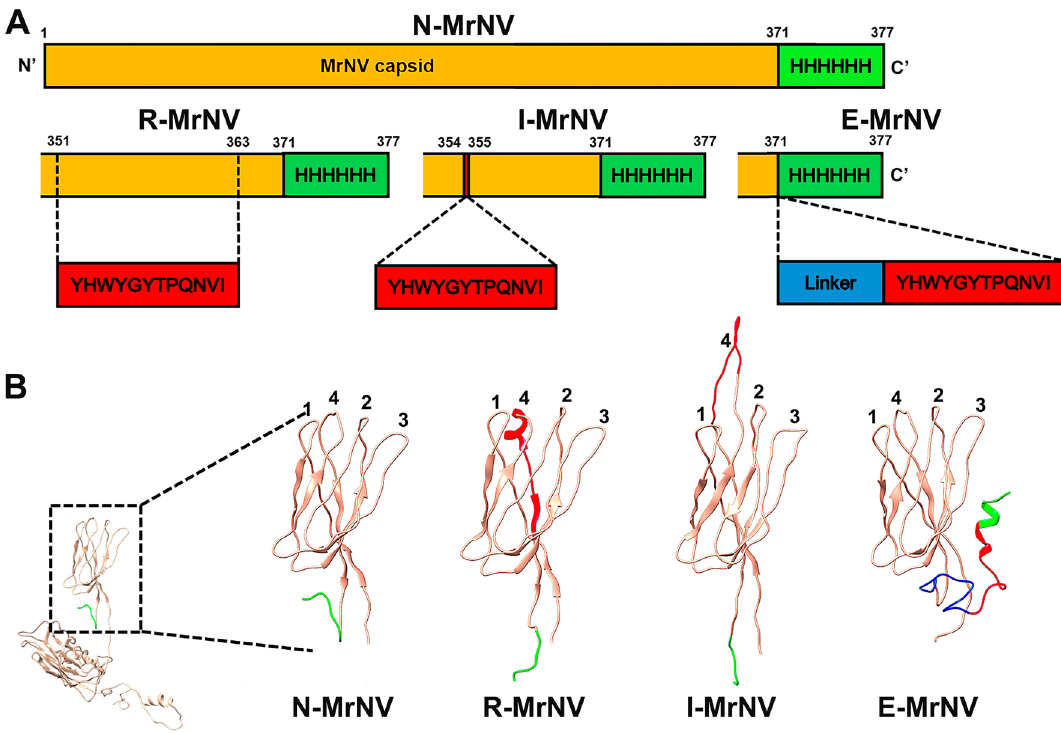
Figure 1. The schematic diagram of the construction of chimeric GE11 + MrNV-VLPs. In silico ribbon diagram of P-domain of 4 typed chimeric MrNV-VLPs including N-MrNV, R-MrNV, I-MrNV, and E-MrNV generated by Phyre2 algorithm version 2.0 (http:// www. sbg. bio. ic. ac. uk/ phyre2) and Chimera software version 1.14 (https:// www. cgl. ucsf. edu/ chime ra). GE11 (red), linker (GGGGS) 3 (blue) and 6 His-tag